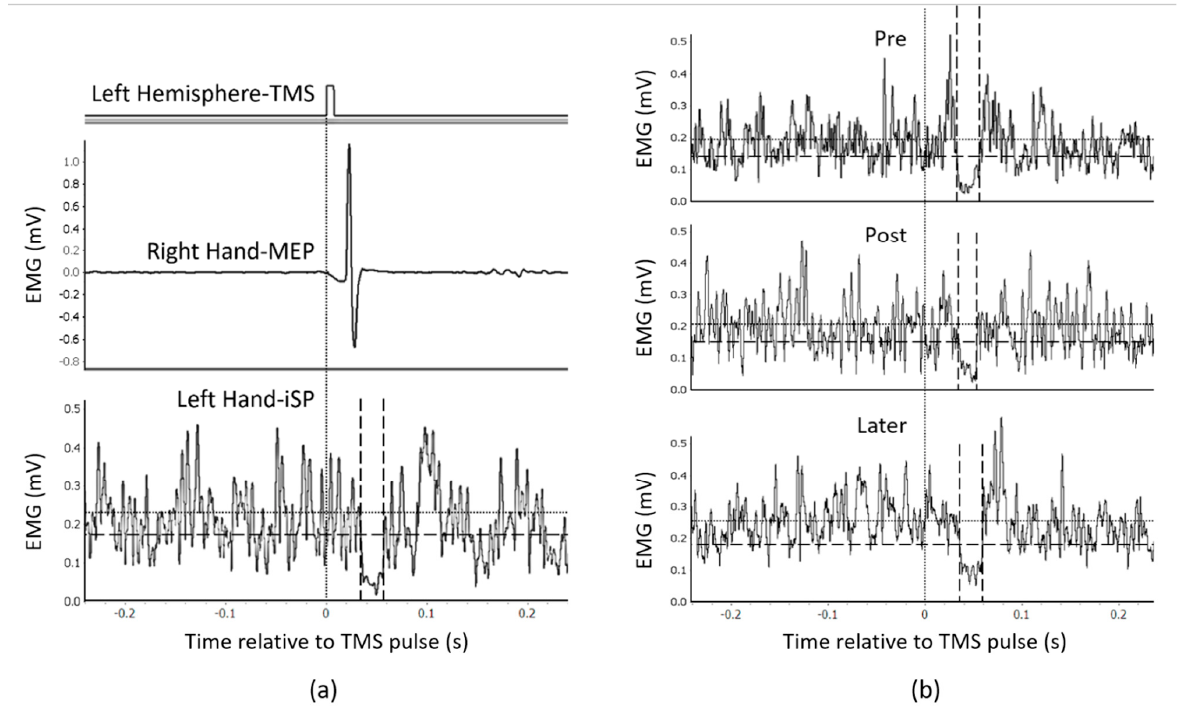
Figure 3. Examples of ipsilateral silent period (iSP) recordings and plastic change analysis. ( a ) An example of iSP measurement (averaged from 10 TMS trials) of a representative participant. TMS was delivered to the left hemisphere. ( b ) Example of a series of plastic change analyses of another representative participant’s EMG data recorded under anatomical imitation condition. The vertical dotted line indicates the time point of the TMS pulse. The horizontal dotted line indicates the average muscle activities 500 ms before TMS, recorded from the APB muscle. The vertical dashed lines indicate the onset/offset of iSP. The horizontal dashed line indicates the threshold for iSP calculation (75% average muscle activities as mentioned in Outcome Measures ).